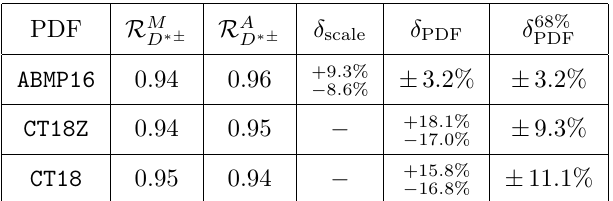
= D ∗± √ s = 13 TeV of ref. [22], using either